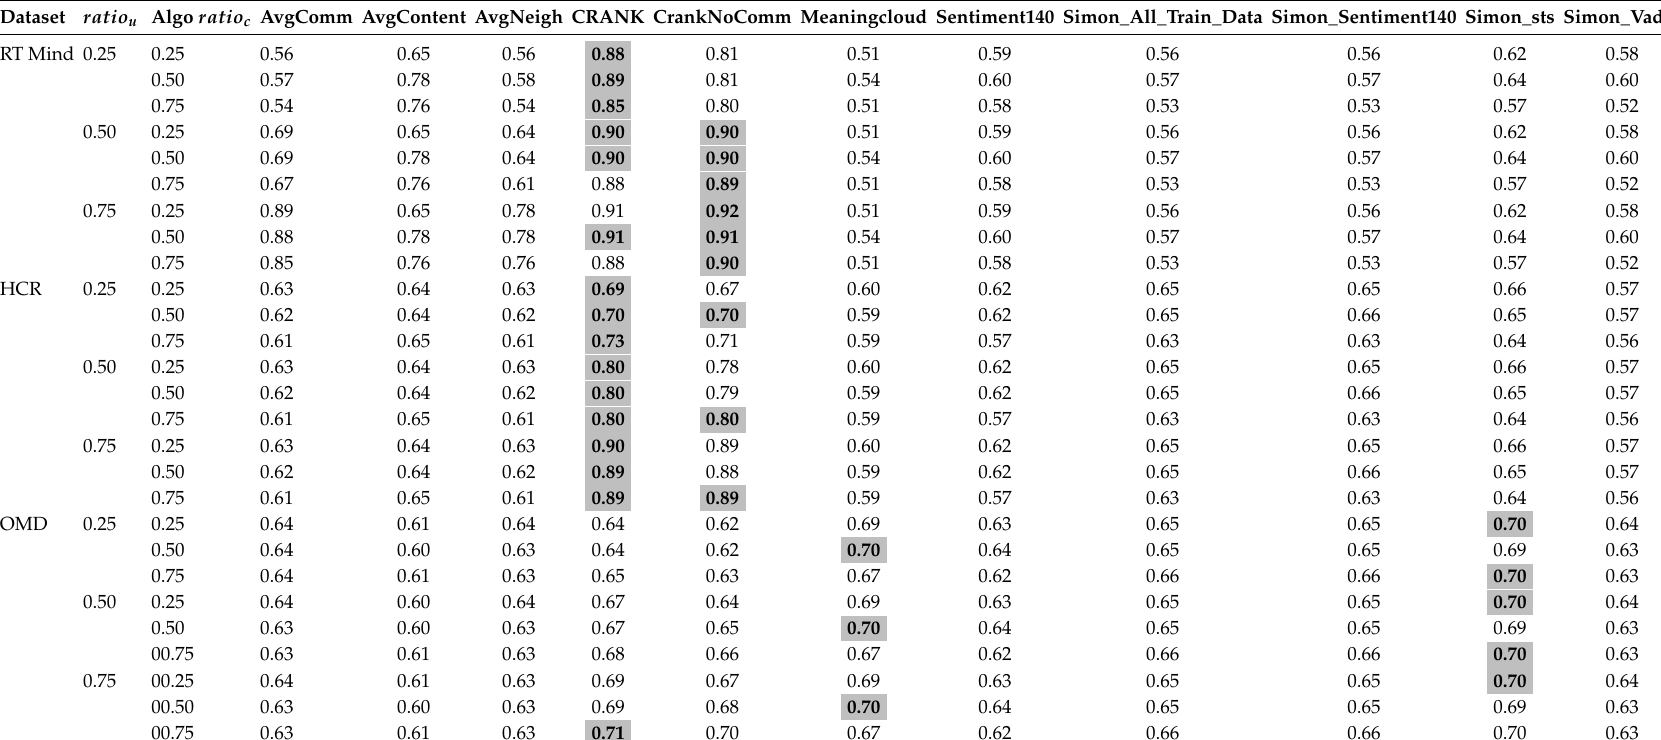
Table 4. Content-level classification accuracy of each